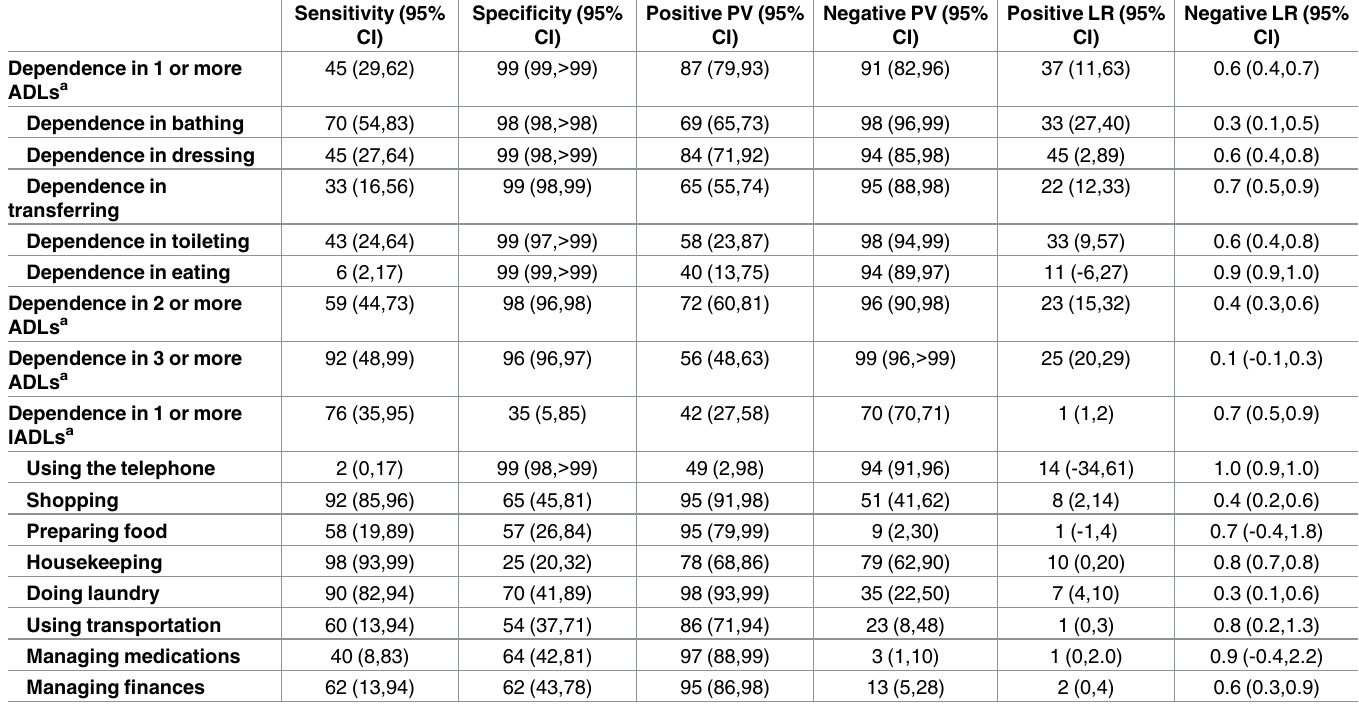
We conducted several sensitivity analyses to better understand the disagreement between the VA and reference standard measures. Eighteen participants categorized as independent in all ADLs by VA data reported dependence in 1 or more ADLs by telephone interview. This included 11 dependent in dressing, 8 in transferring, 5 in eating, 3 in bathing, and 2 in toilet- ing. The sensitivity of the VA data for detecting ADL dependence did not substantially improve in analyses excluding the ADLs with the most disagreement between measures Table 4. Sample-weighted test characteristics of VA functional status data compared with the referencestandard of research-collected